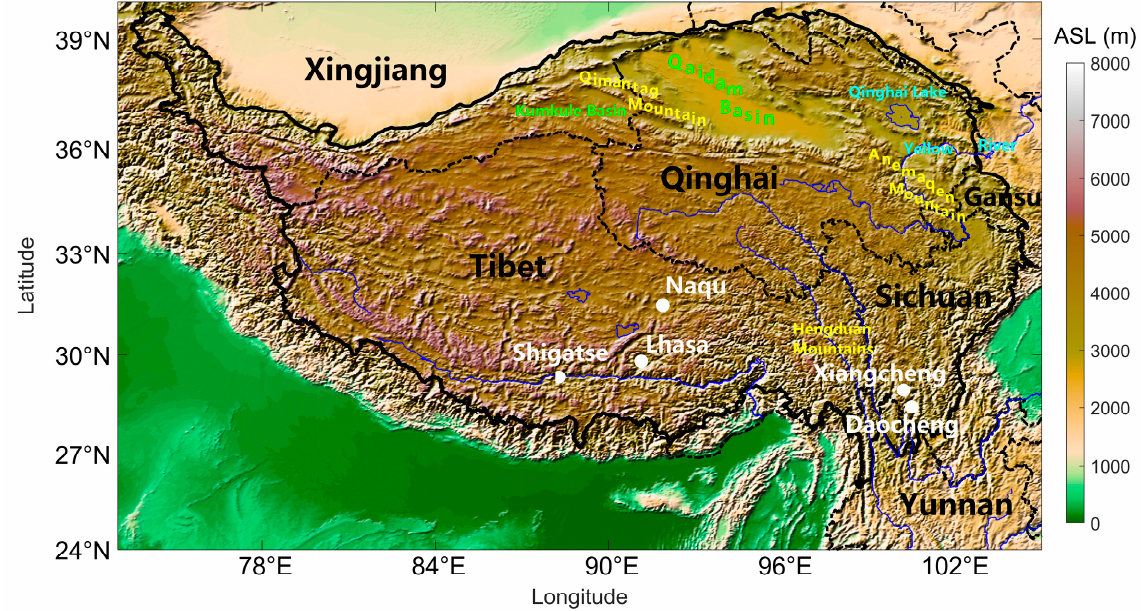
Figure 2. The study area delineated by the black solid line. Some place names are marked; they will be mentioned in the subsequent analysis.